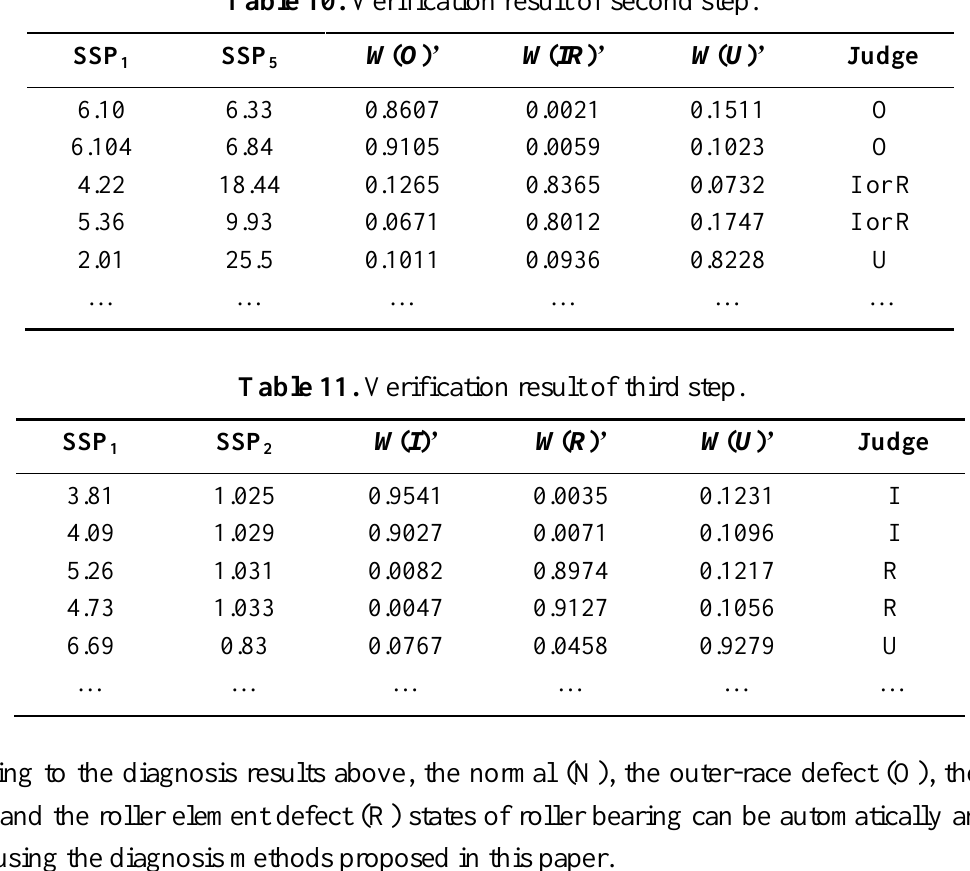
Table 10. Verification result of second step.